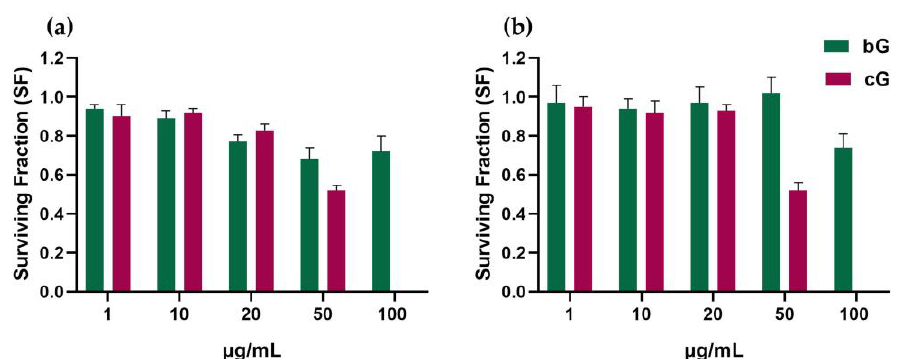
Figure 4. Clonogenic assay in NIH/3T3 ( a ) and HaCaT cells ( b ) after incubation with increased doses of bG and cG for 48 h. of bG and cG for 48